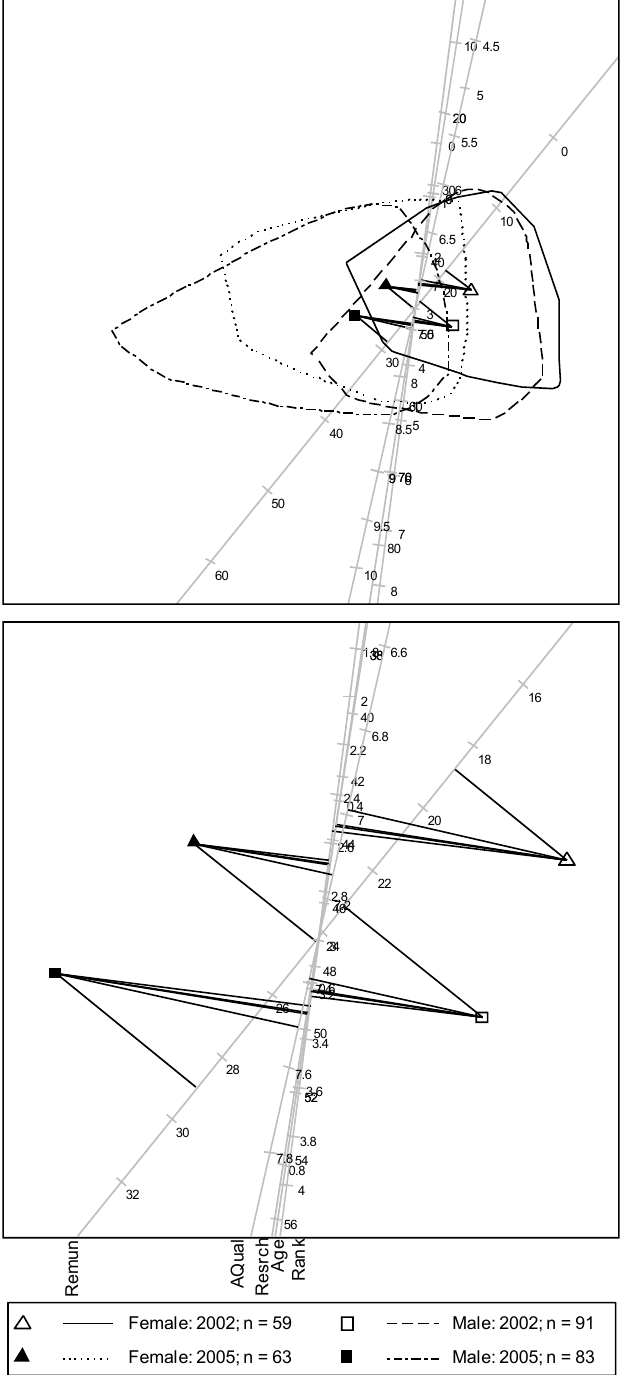
Figure 3: CVA biplot separating C1 staff in the Faculty of Arts according to the 2002 Female, 2005 Female, 2002 Male and 2005 Male subgroups. Plotting of data points is suppressed. The upper panel shows the biplot overlaid with 90% bags. The bottom panel shows the group means on a large scale together with perpendicular lines from each group mean to the five axes for determining the biplot predictions of the different